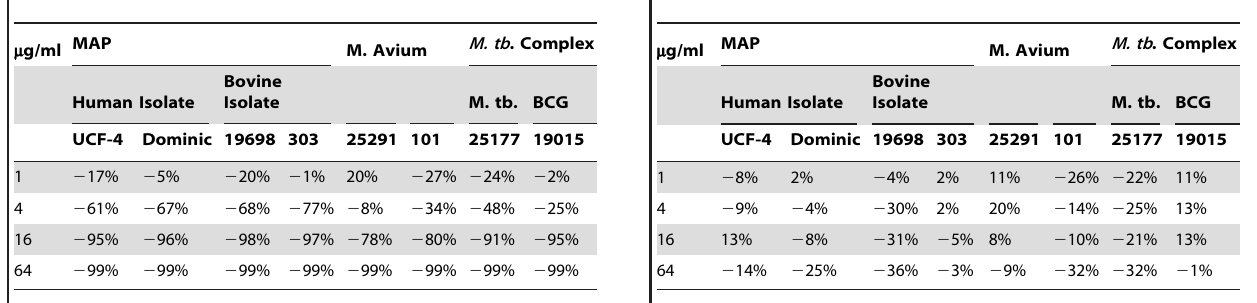
Table 3. Vitamin A: retinol.